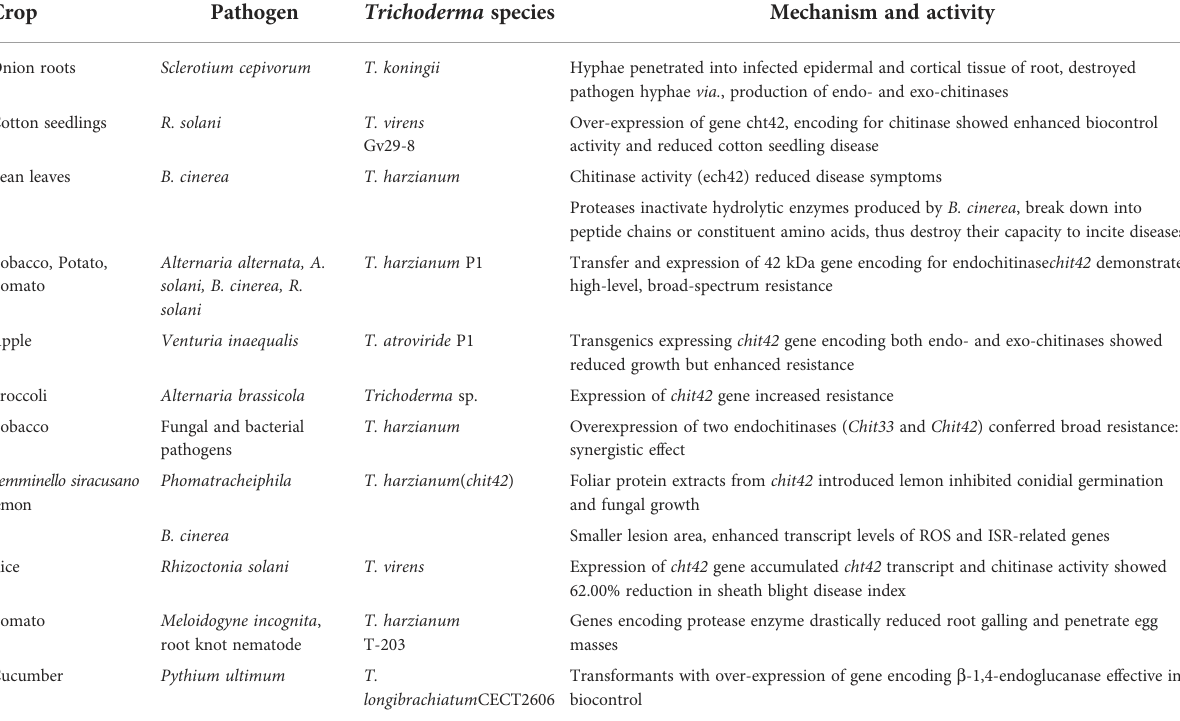
TABLE 5 Genetic manipulation using Trichoderma spp. in different crops conferred disease